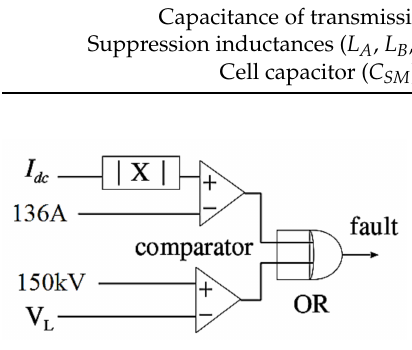
Figure 15. Fault detection